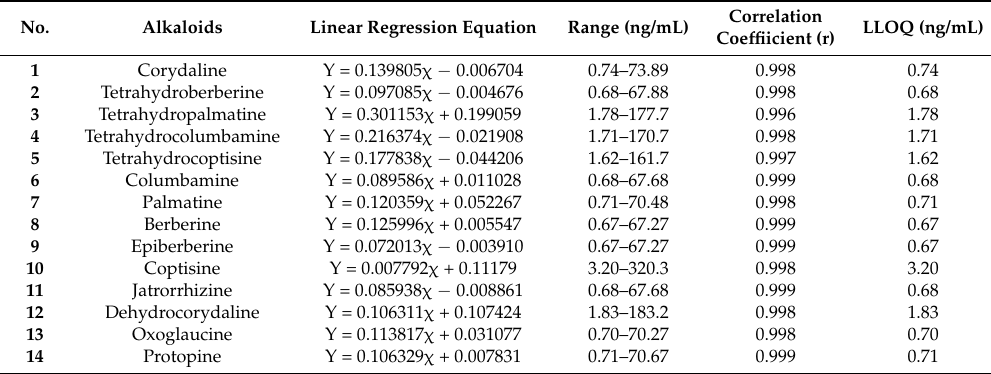
Table 2. The regress equations, linear range, and LLOQs of the fourteen